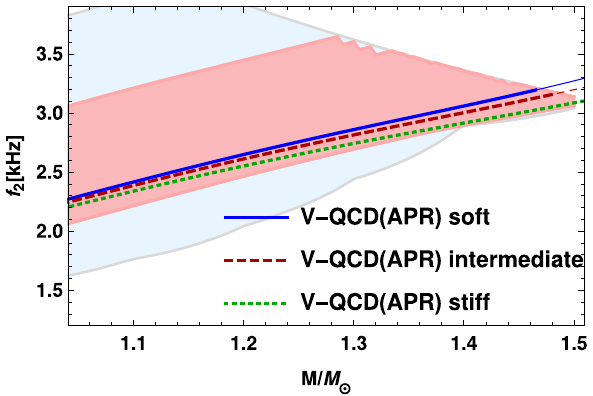
Fig. 23 The power spectral density for the merger of two M = 1 . 3 M (cid:3) neutron stars with the V-QCD(SLy) EOS with n tr = 1 . 61. The dashed and solid curves are with and without including the inspiral part of the signal. I also compare to the sensitivity of advanced LIGO/Virgo and the projected sensitivity of the Einstein telescope assuming the distance 40 Mpc of GW170817